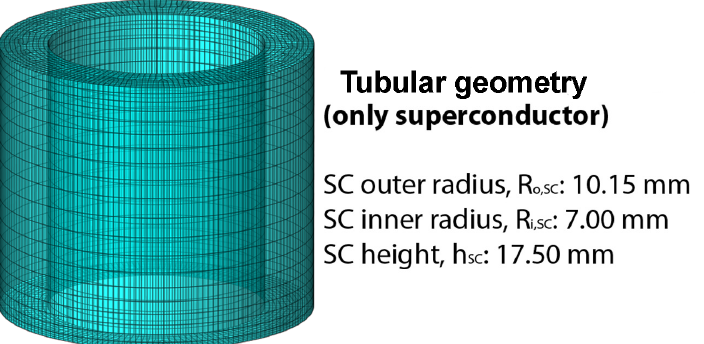
Figure 1. Schematic view of the SC shielding layout investigated with both the A - and H